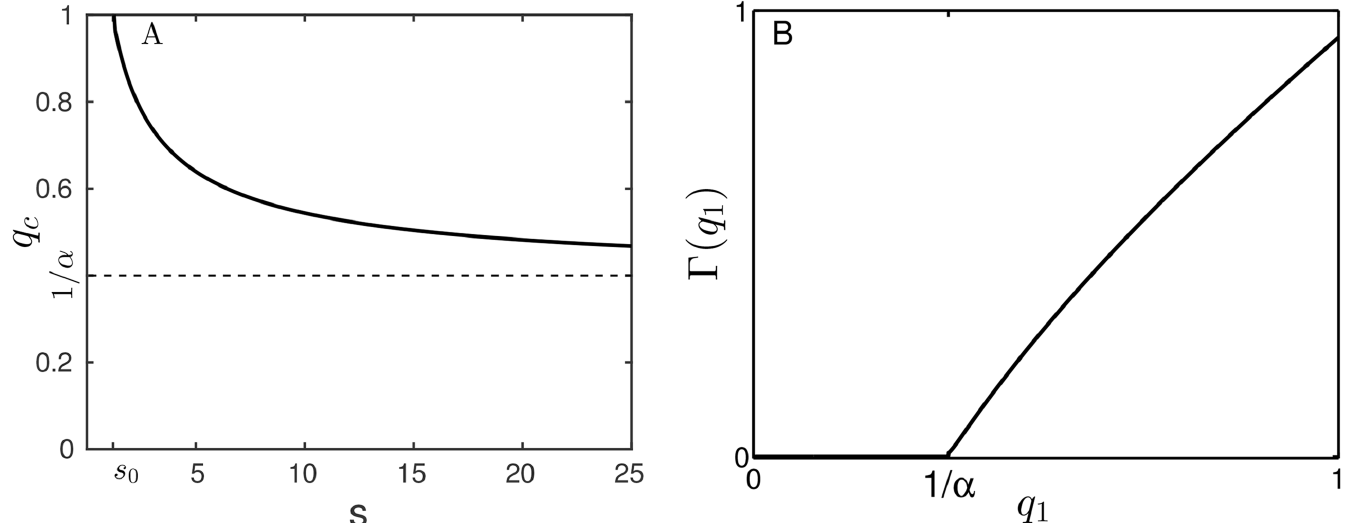
Fig 5. Steady-state of a monomorphic population with trait value q 1 . (A) Over time, mutations drive q 1 towards 1 if s < s 0 and towards q c otherwise ( q c is the convergence stable strategy [38, 52]). (B) The steady state total abundance of the population approaches Γ ( q 1 ) at steady state: R